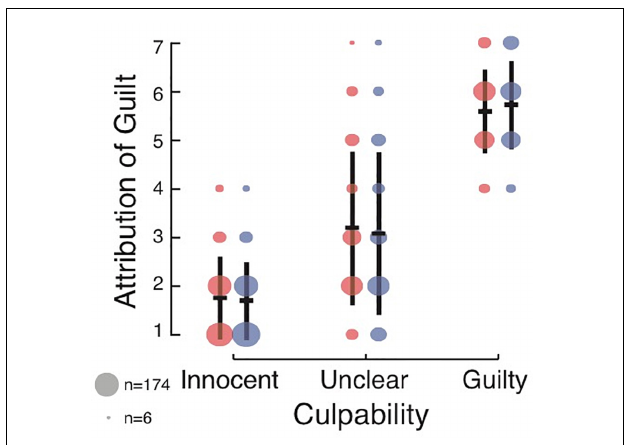
FIGURE 3 | Effect of culpability and DSF language on rating of intent to kill in Experiment 3. Annotation is the same as that used in Figures 1 , 2